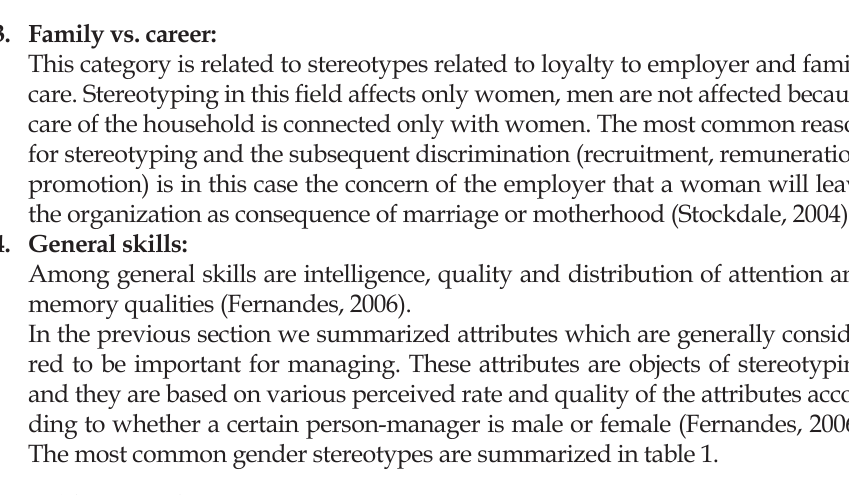
Table 1: Gender stereotypes in